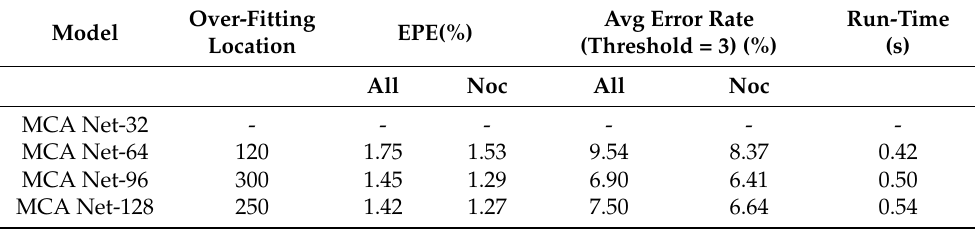
Table 1. Multi-level cost volume ablation experiment on